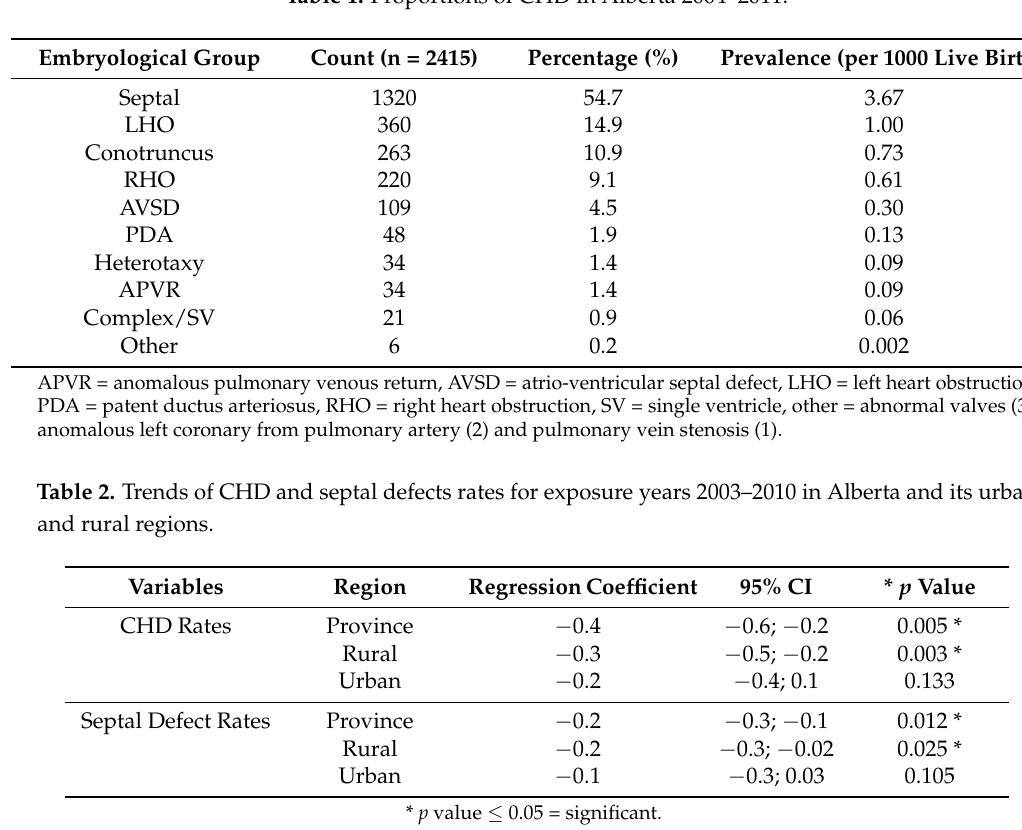
Table 1. Proportions of CHD in Alberta 2004–2011.